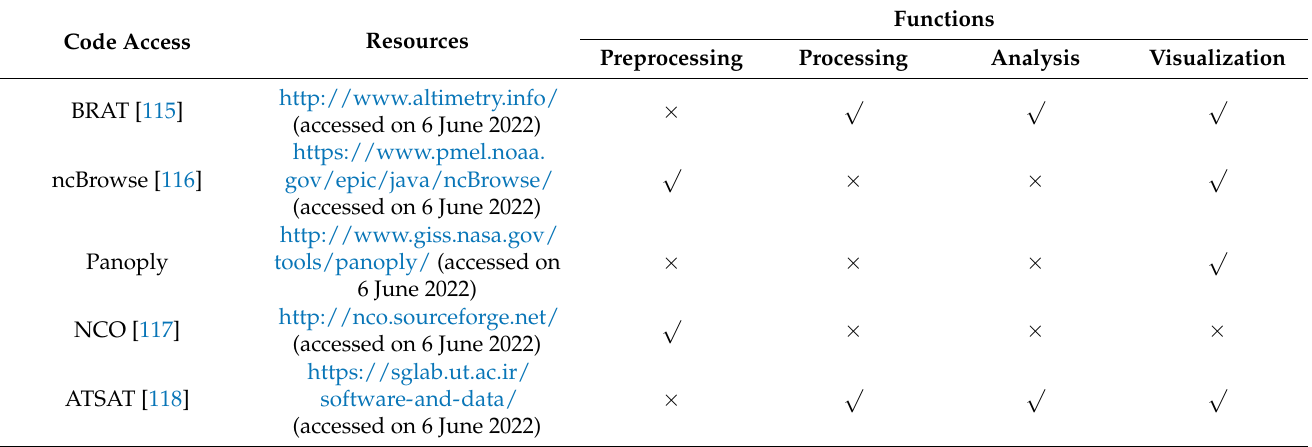
Table 4. Programs for processing altimetry